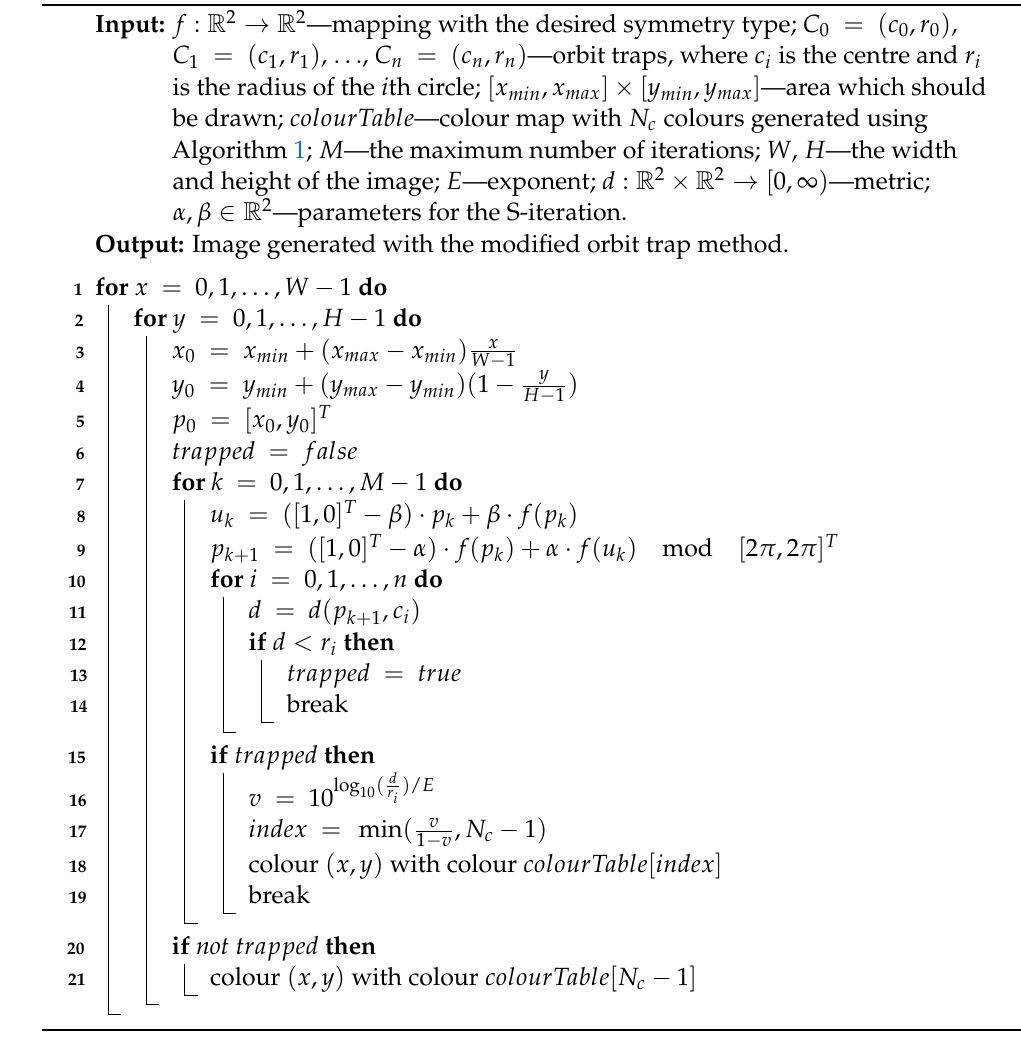
Algorithm 3: Modified orbit trap method.